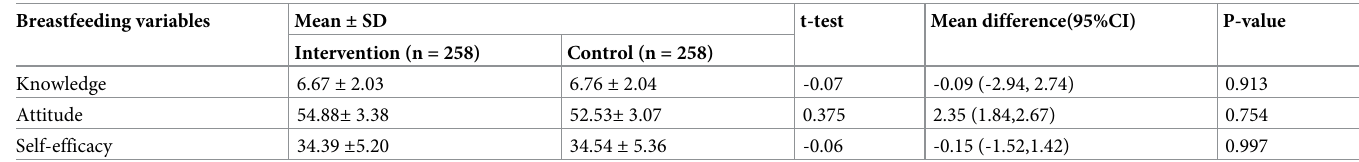
Table 2. Baseline comparison of the mean total breastfeeding knowledge, attitude and self-efficacy scores of the intervention and control groups. Breastfeeding